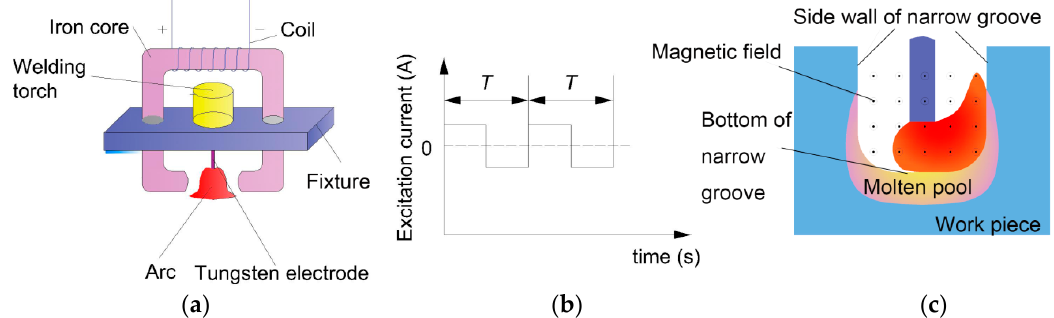
Figure 1. Schematic of magnetic oscillation arc narrow gap gas tungsten arc welding (MOA-NG-GTAW): ( a ) Magnetic field generator; ( b ) Waveform of magnetic excitation current; ( c ) Deflecting welding arc.